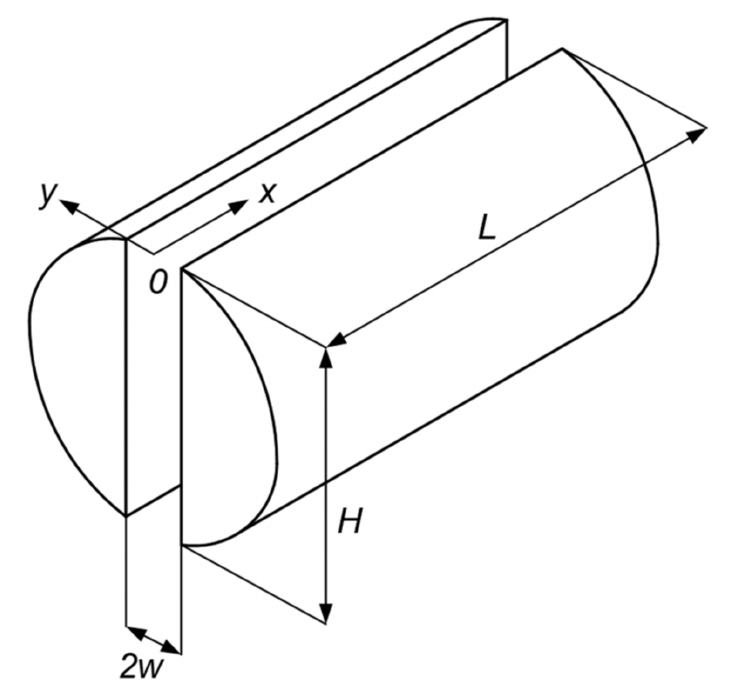
Figure 5. The tested fractured rock sample is assumed to have a single fracture of aperture 2 w , height H and length L